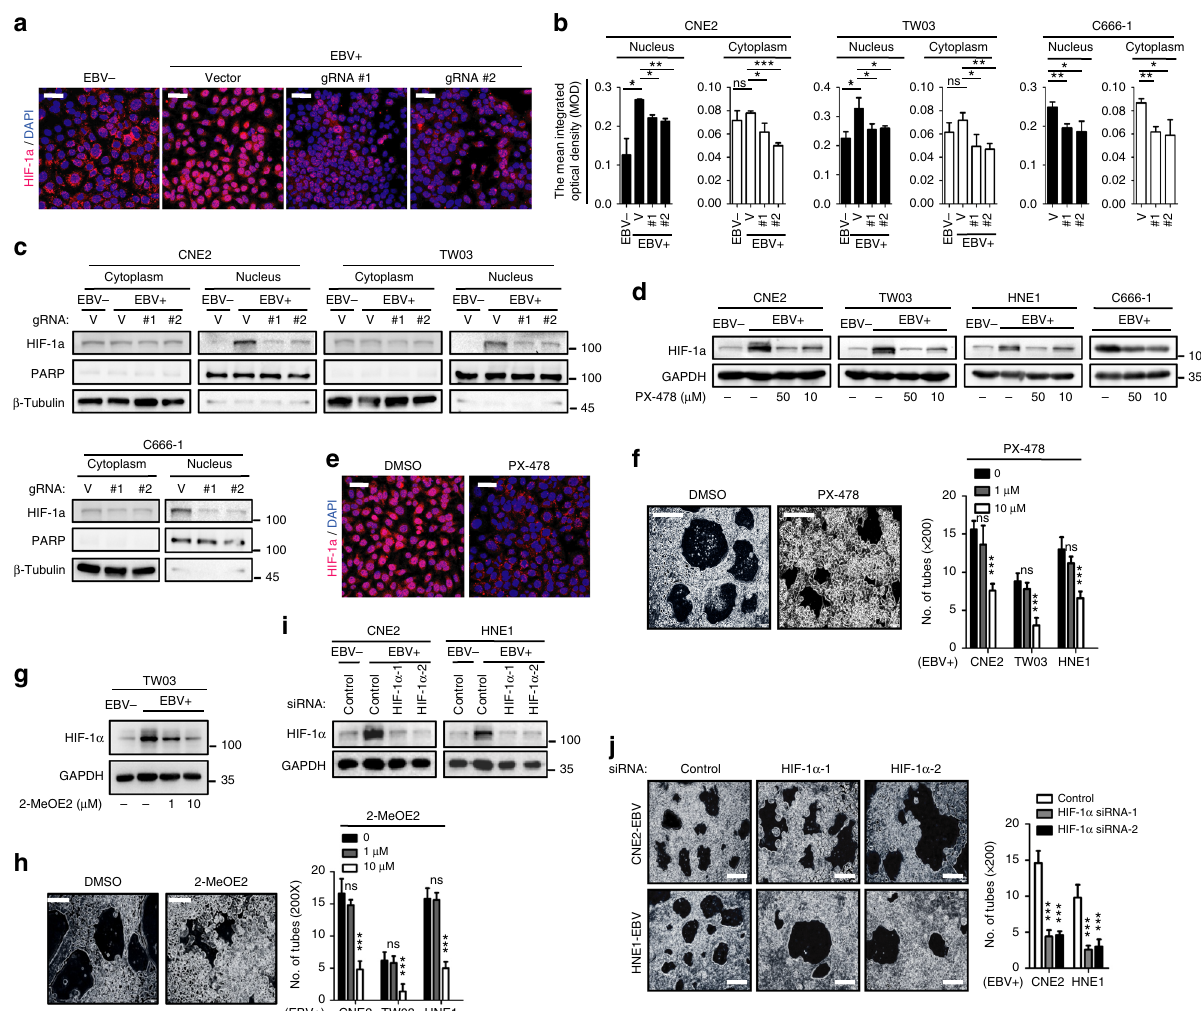
Fig. 4 EBV-induced VM formation is HIF-1 α -dependent. a Immuno fl uorescence of HIF-1 α in TW03 and TW03-EBV cells with or without targeting of EBV by CRISPR/Cas9. Scale bars = 50 μ m. b The mean integrated optical density (MOD) values of HIF-1 α levels in the cytoplasm and nucleus of NPC cells with or without EBV. More than 100 cells were counted in randomly chosen fi elds. Mean± SD, n = 3, two-tailed unpaired t -test. c Subcellular fractionation of EBV- cells, EBV + cells and EBV + cells subjected to EBV targeting by transfecting EBNA1 gRNAs. Each extract was analyzed by immunoblotting of HIF-1 α , β - Tubulin, and PARP1. β -Tubulin represents cytoplasmic proteins, and PARP1 is used as a nuclear protein marker. d EBV − and EBV + NPC cells were treated with 10 or 50 μ M PX-478 for 24 h, followed by WB analysis of HIF-1 α . e Immuno fl uorescence staining of HIF-1 α in TW03-EBV cells that were treated with 10 μ M PX-478 for 24 h or left untreated. Scale bars = 50 μ m. f (left) Light microscopy of the tube formation of TW03-EBV cells that were pre-treated with 10 μ M PX-478 for 24 h prior to plating on Matrigel for additional 12 h. Scale bars = 100 μ m. (right) Quanti fi cation of the tube numbers formed by NPC-EBV cells after PX-478 treatment at different concentrations, as indicated. Mean ± SD, n = 5, two-tailed unpaired t -test. g EBV- and EBV + TW03 cells were treated with 1 or 10 μ M 2-MeOE2 for 12 h, followed by WB analysis of HIF-1 α . h (left) In vitro tube formation of TW03-EBV cells that were treated with DMSO or 10 μ M 2-MeOE2 for 12 h on Matrigel. Scale bars = 100 μ m. (right) Quanti fi cation of tube numbers formed by NPC-EBV cells after 2-MeOE2 treatment. Mean± SD, n = 5, two-tailed Mann – Whitney test. i Immunoblotting of NPC cells transfected with control or HIF-1 α -speci fi c siRNAs. j (left) Images and (right) quanti fi cation of tube formation of control and HIF-1 α -depleted cells. Scale bars = 100 μ m. Mean ± SD, n = 5, two-tailed Mann – Whitney test. ns: not signi fi cant, * p < 0.05, ** p < 0.01 and *** p <